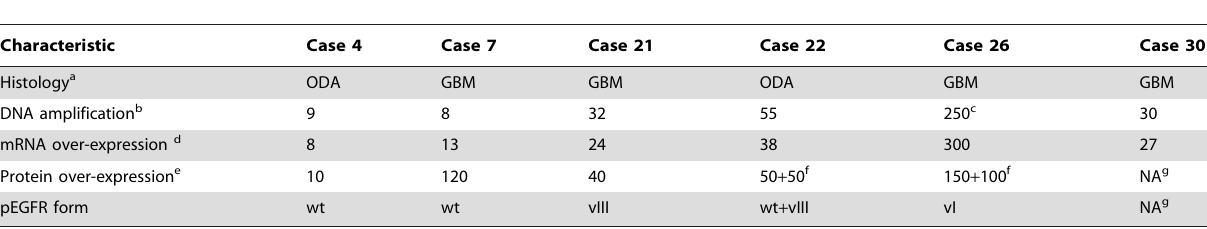
ODA: oligodendroglioma; GMB: glioblastoma multiforme. a Histological